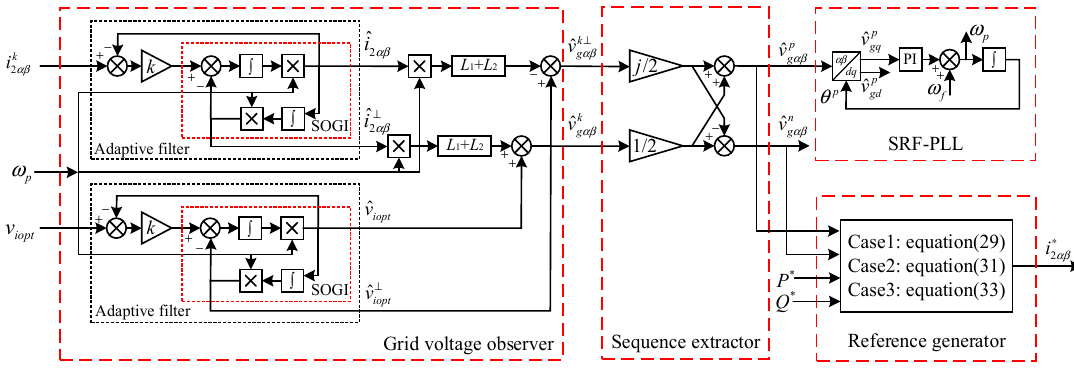
Figure 2. The block diagram of the proposed strategy under the unbalanced grid voltage condition.